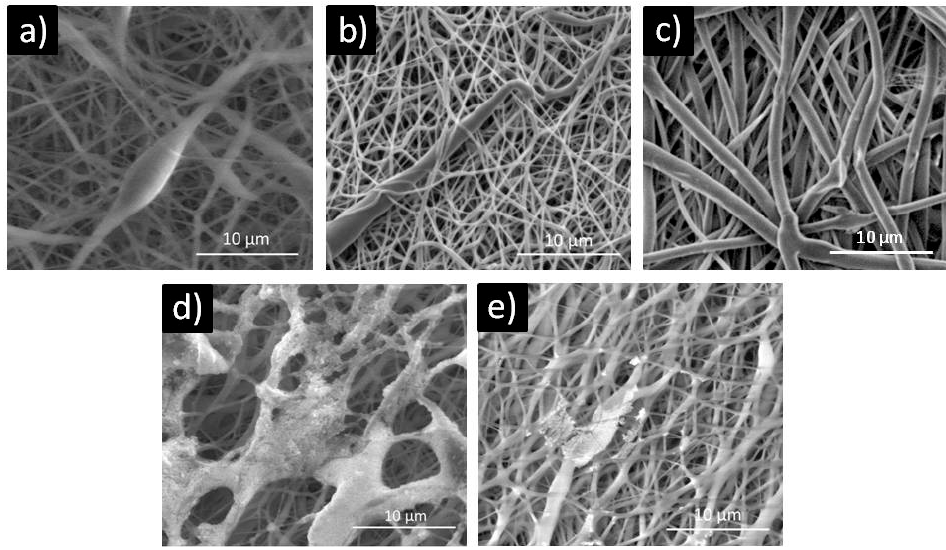
Figure 3. Scanning electron microscopy (SEM) photomicrographs of the electrospun scaffolds: ( a ) poly( ε -caprolactone) (PCL) with randomly beaded fibers, ( b ) PCL/5 wt % CF and ( c ) PCL/25 wt % CF with uniform fibers, ( d ) PCL/n-TiO 2 and e) PCL/m-TiO 2 with surface particle agglomerations.